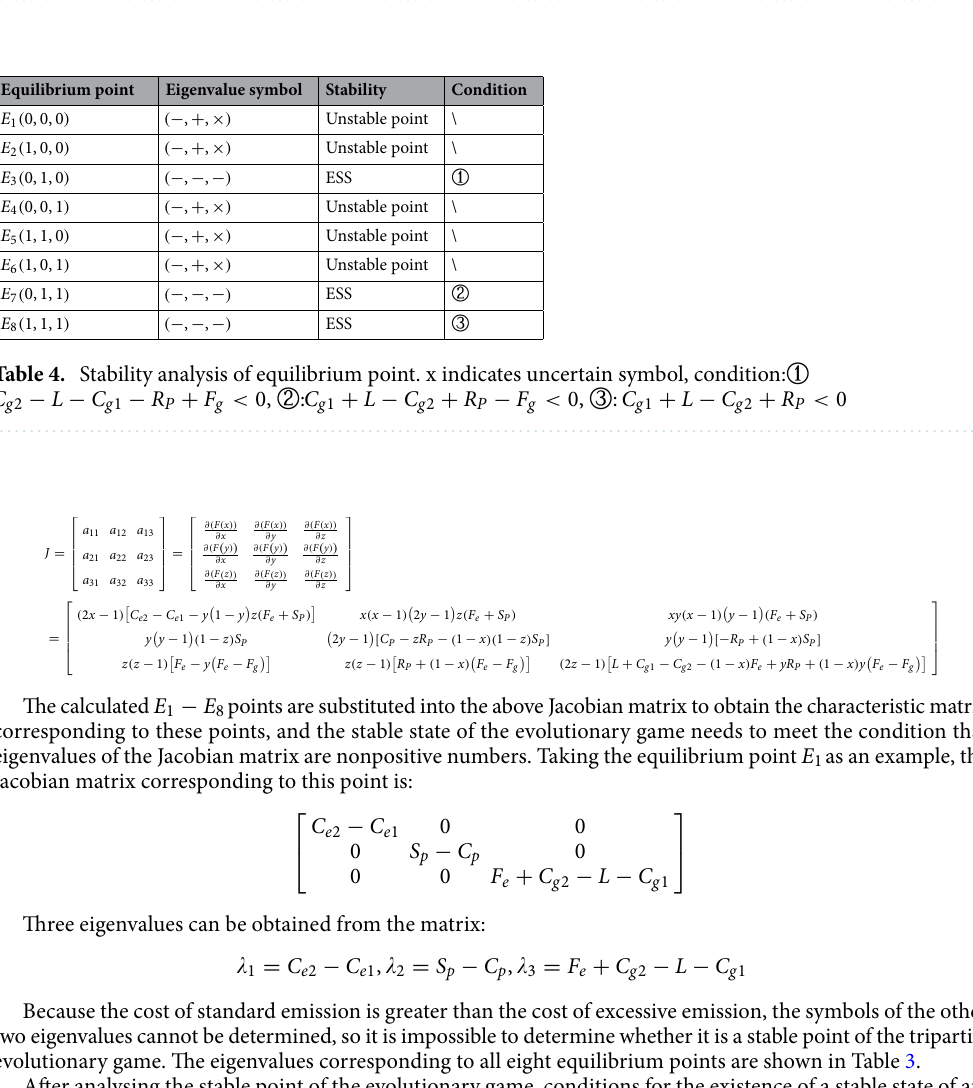
Table 3. Eigenvalues of the Jacobian matrix corresponding to each equilibrium point.